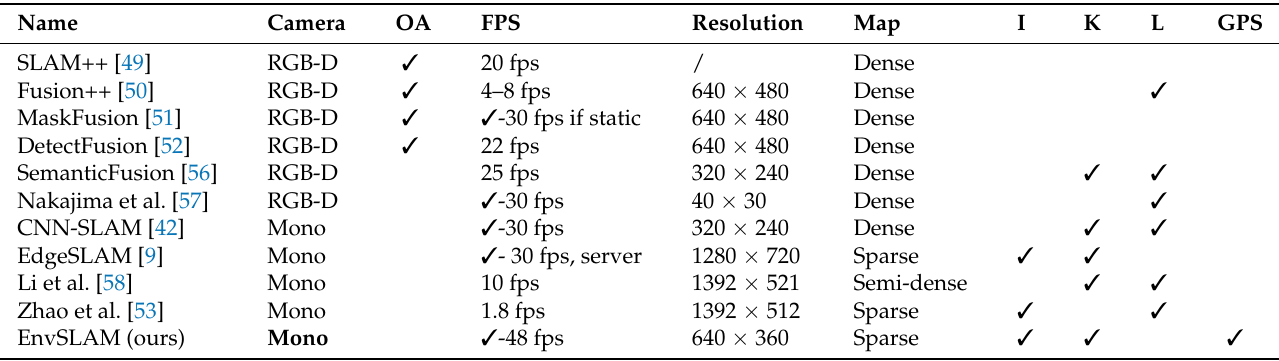
Table 1. OA stands for object-aware map and Mono for monocular, while server in the Resolution column indicates that an external server performs computations. The FPS (frames per second) column contains a tick symbol when the methods run in real-time. Thereby the FPS numbers are directly taken from their corresponding publications and, thus, are measured on different machines. Resolution refers to neural networks’ input resolution. The last four columns state if the system is based on an (I)ndirect SLAM, if the network is applied only on (K)eyframes, if (L)abel fusion is performed and if the GPS information is used to improve the network